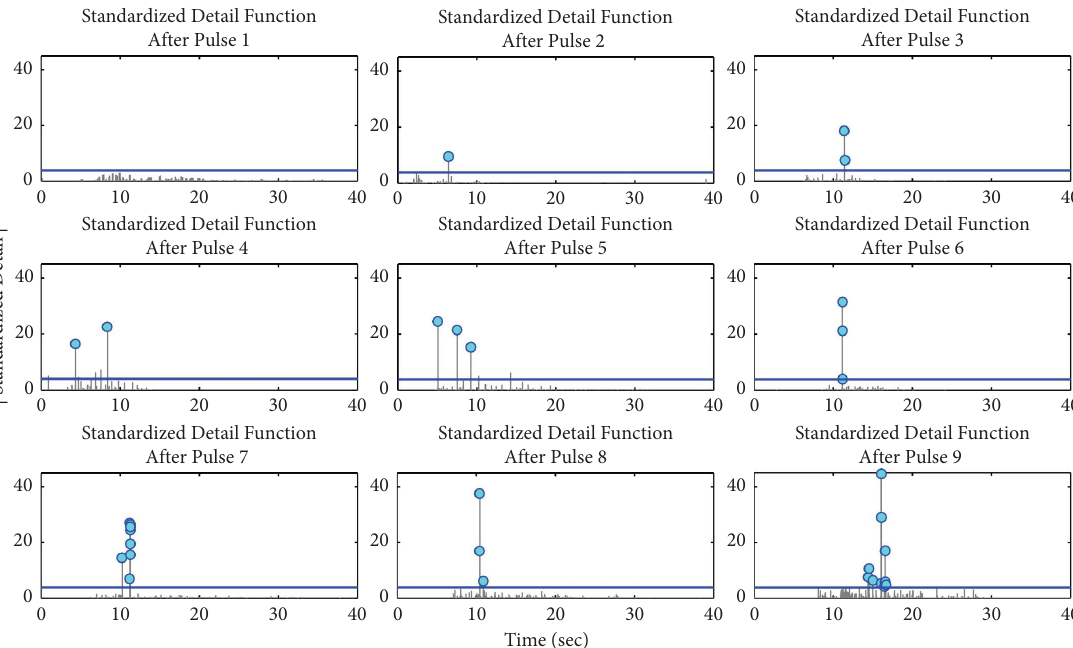
Figure 12: Standardized decomposed details of acceleration response due to all